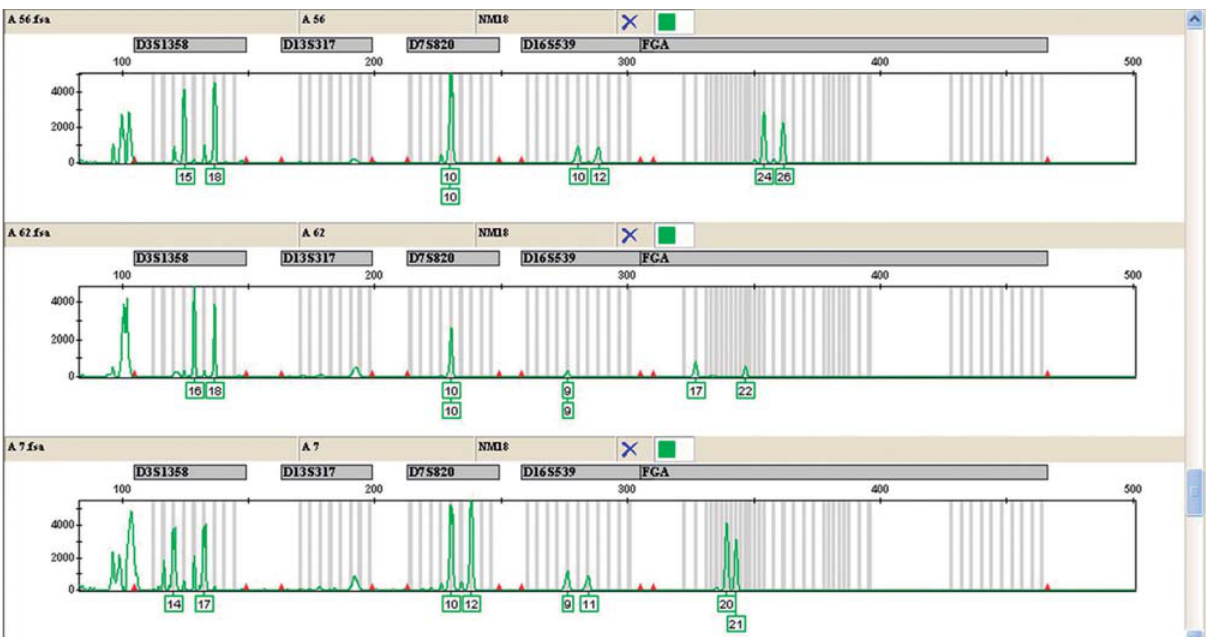
Figure 2- Image of the Gene Mapper™ ID software (Applied Biosystems, USA) for the STR analysis in three differents